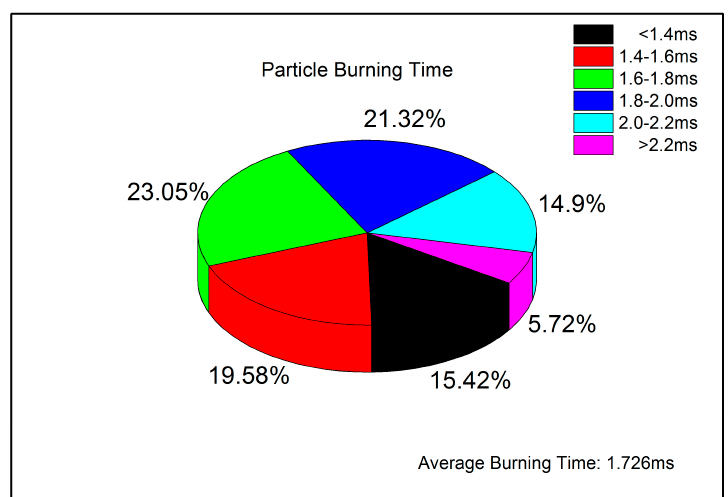
Figure 9. Ignition delay time distribution of Al particles.